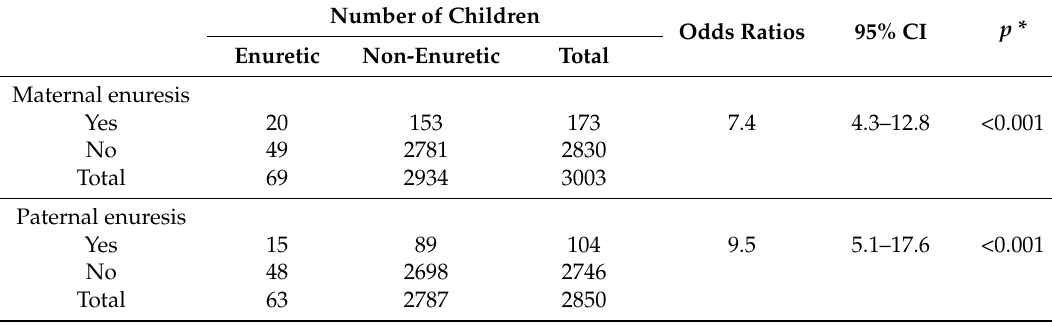
Table 2. Odds ratios for enuresis according to positive parental history of enuresis.